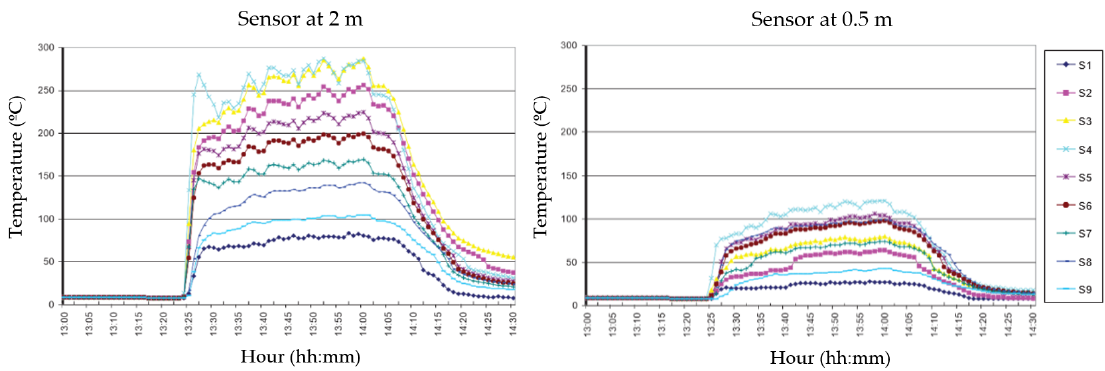
Figure 11. Evolution of the temperature along the drift at different heights; scenario 2.